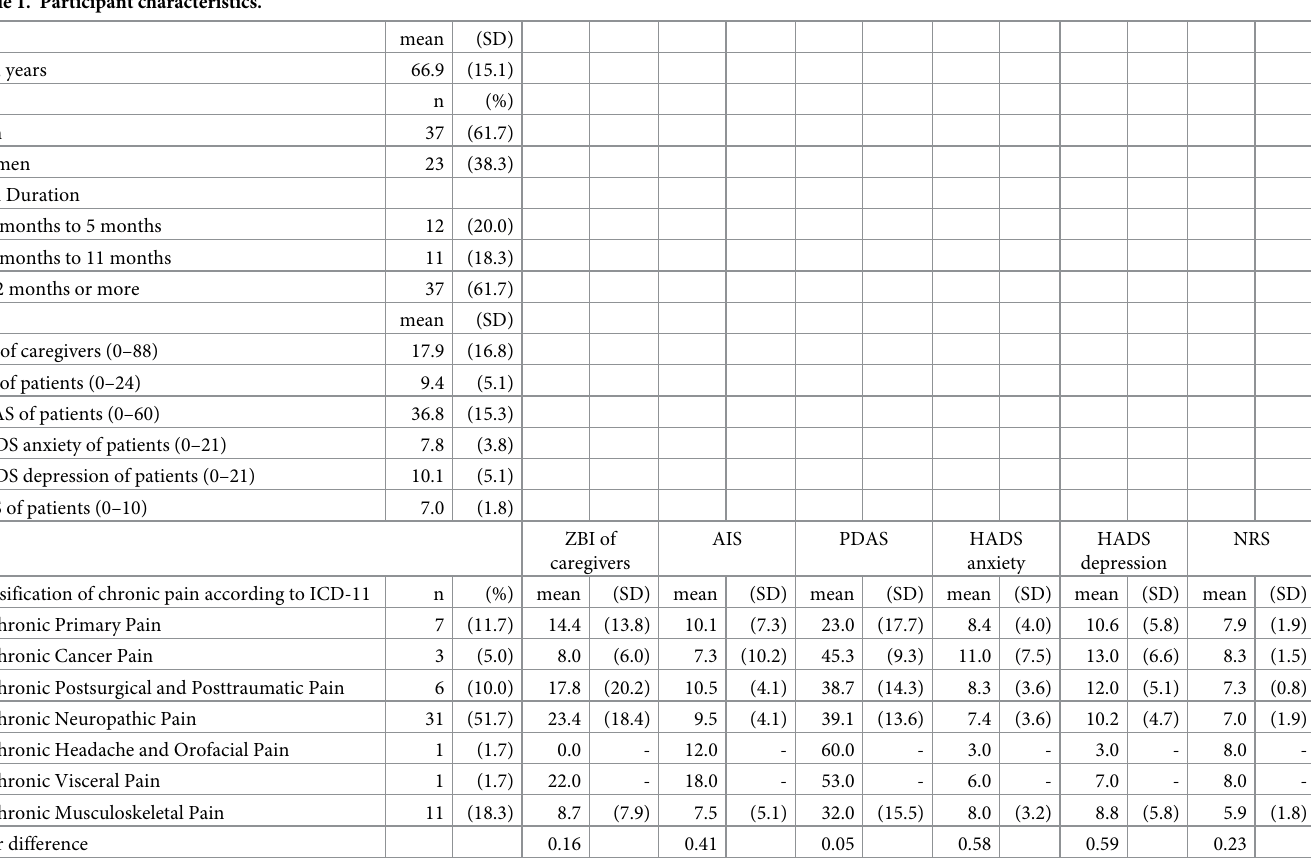
Table 1. Participant characteristics.